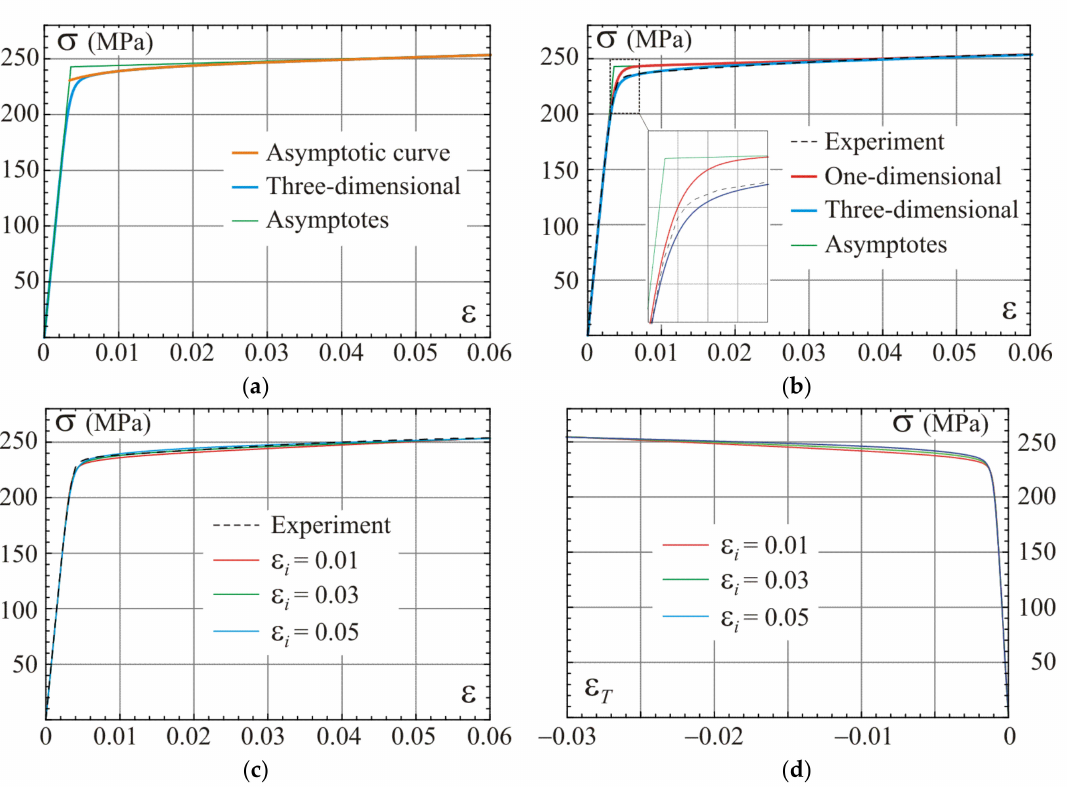
Figure 7. Stress–strain relation for compressible material: ( a ) asymptotic curve according to Equations (63) and (64) with asymptotes, ( b ) one-dimensional model and uniaxial tension of the three-dimensional model with asymptotes and experiment; and ( c ) comparison of calibrated three uniaxial tension curves with experiment, ( d ) comparison for transverse strain for three selected calibration